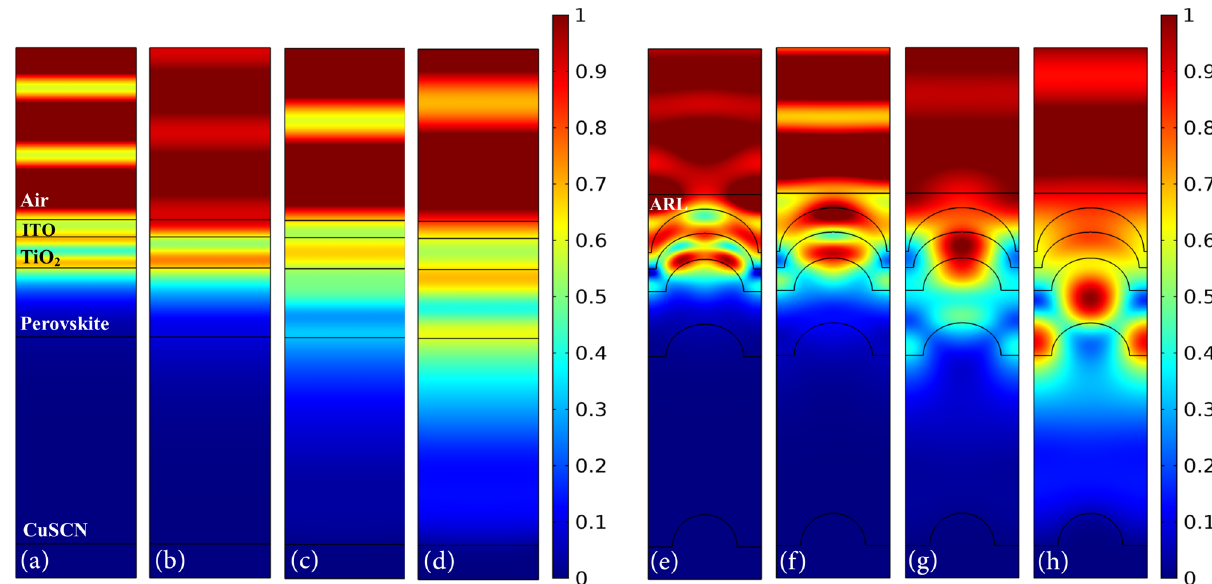
Fig. 6. Profile of normalized electric field for the planar and proposed structures. ( a , e ) At the wavelength of 390 nm, ( b , f ) at 480 nm, ( c , g ) at 630 nm, and ( d , h ) at 800